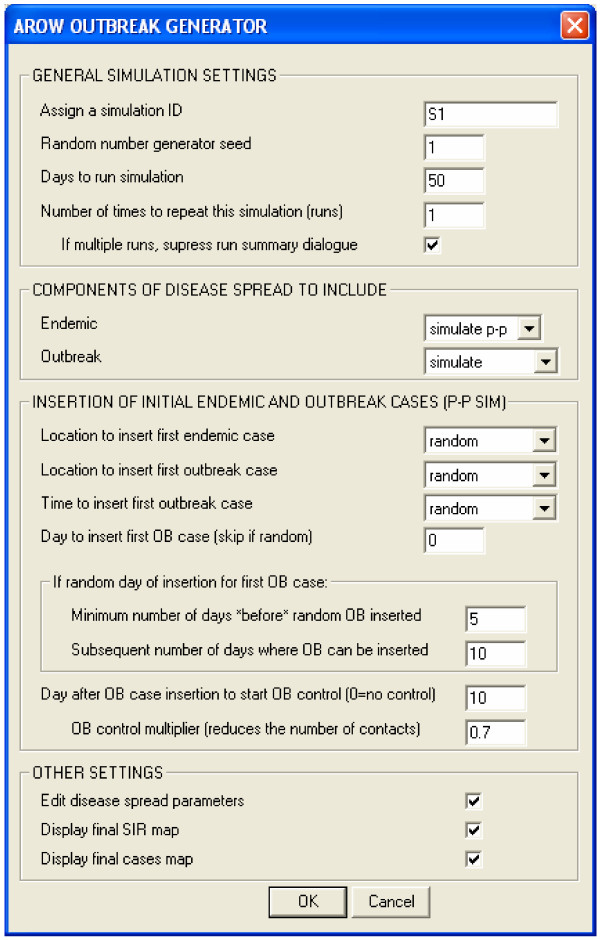
Start-up dialog.